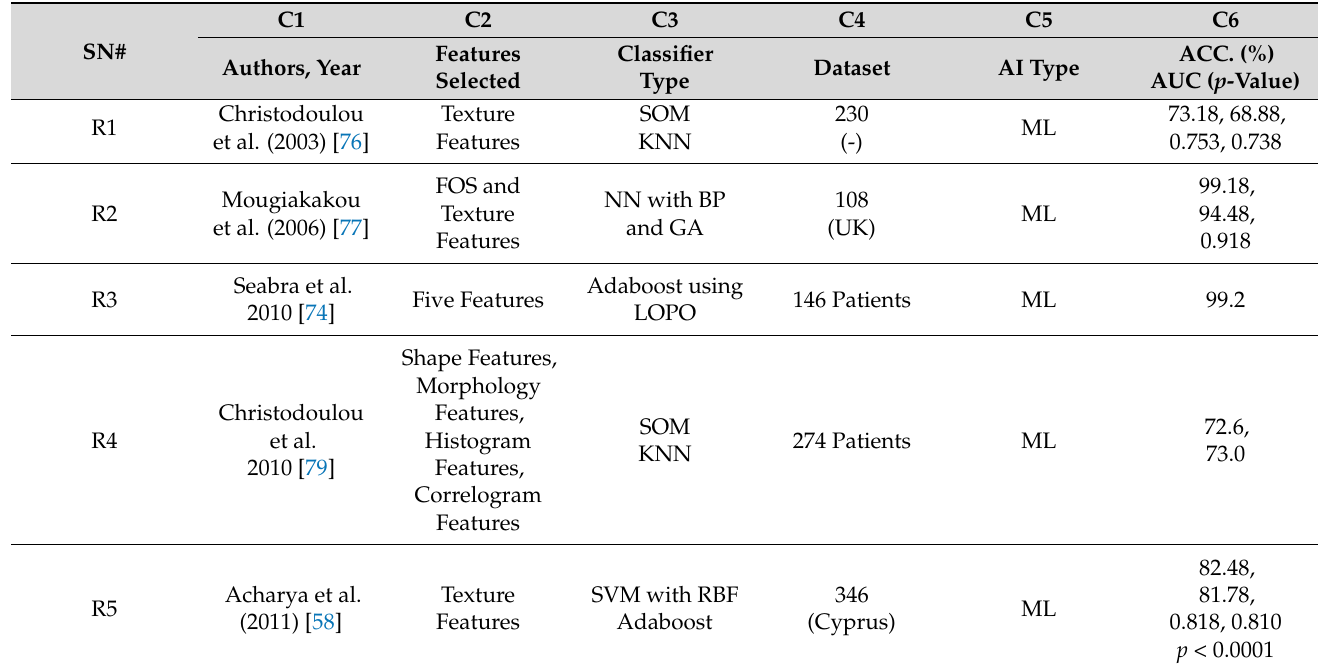
Table 7. Benchmarking